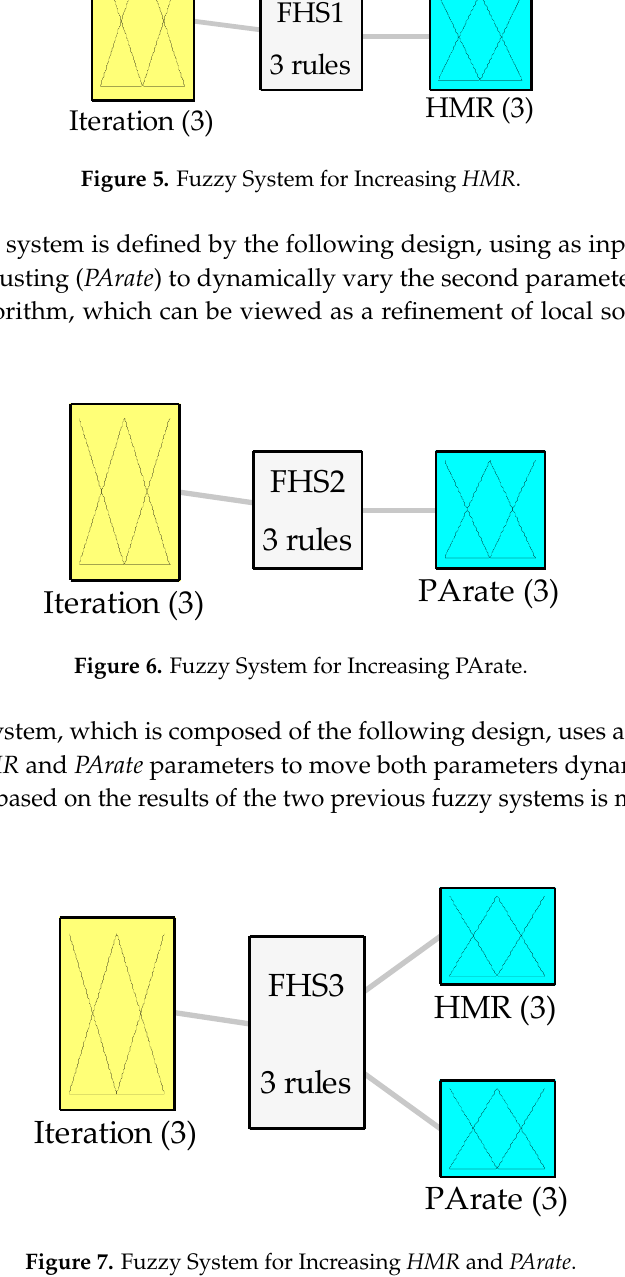
Figure 7. Fuzzy System for Increasing HMR and PArate.